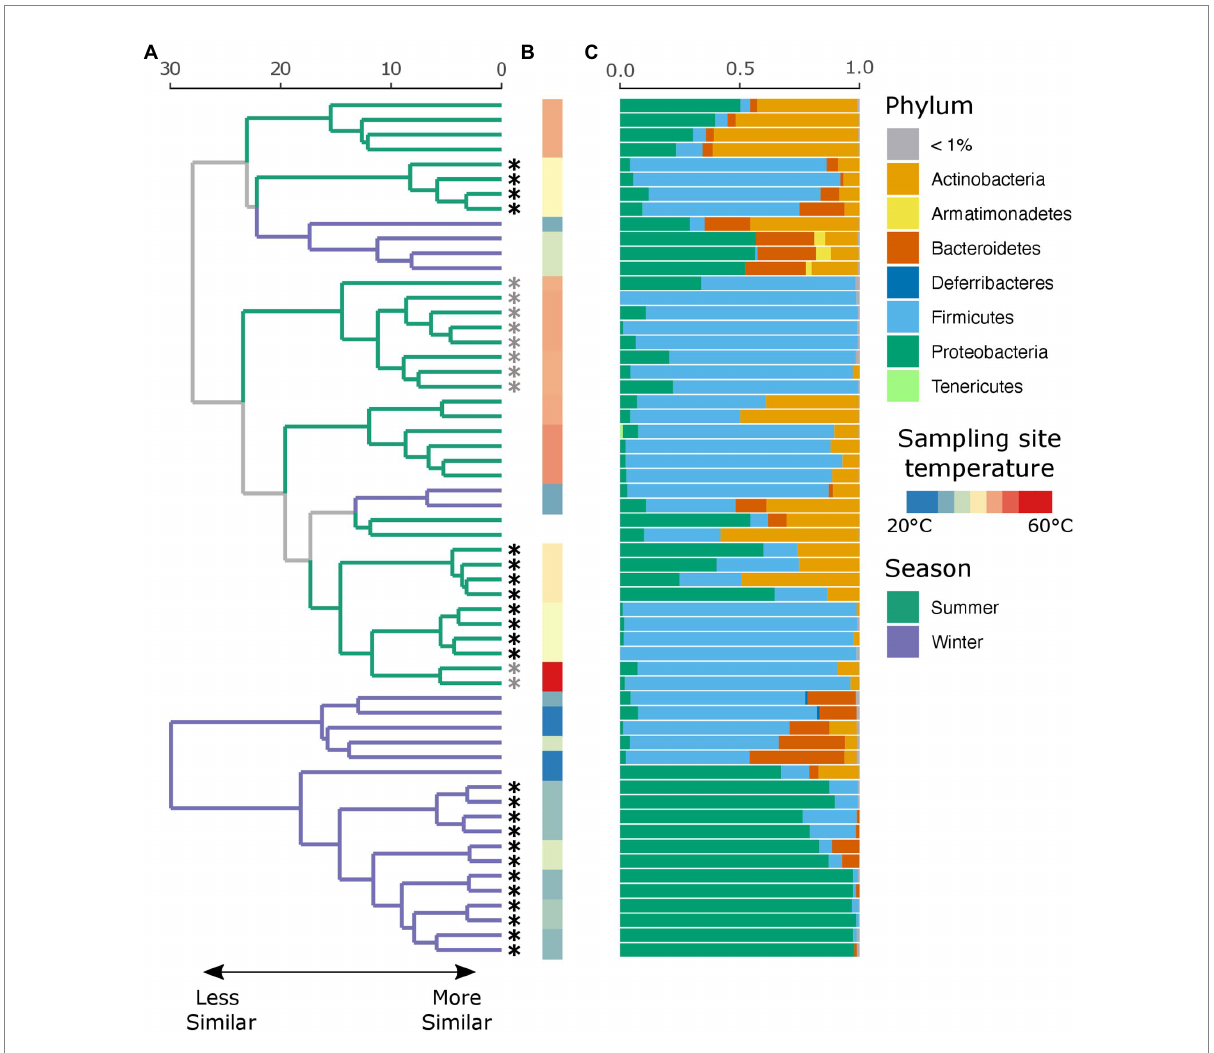
FIGURE 2 Local clustering of samples by season, surface temperature, and presence of insects. (A) Hierarchical cluster dendrogram of PhILR transformed beta diversity. Each branch tip represents a single sample. Colors on branches indicate whether the sample was collected in the summer (green) or winter (purple). Asterisks (*) at tips indicate that insects were present at the time of sampling. Gray asterisks denote samples where insects were present but not at the sampling site (nostril). Black asterisks indicate samples where insects were in the nares. (B) Surface temperature at time of sampling as measured by thermal imaging corresponding. Two samples had no recorded temperature and were thus left blank. (C) Relative abundance of taxa at the phylum level for each